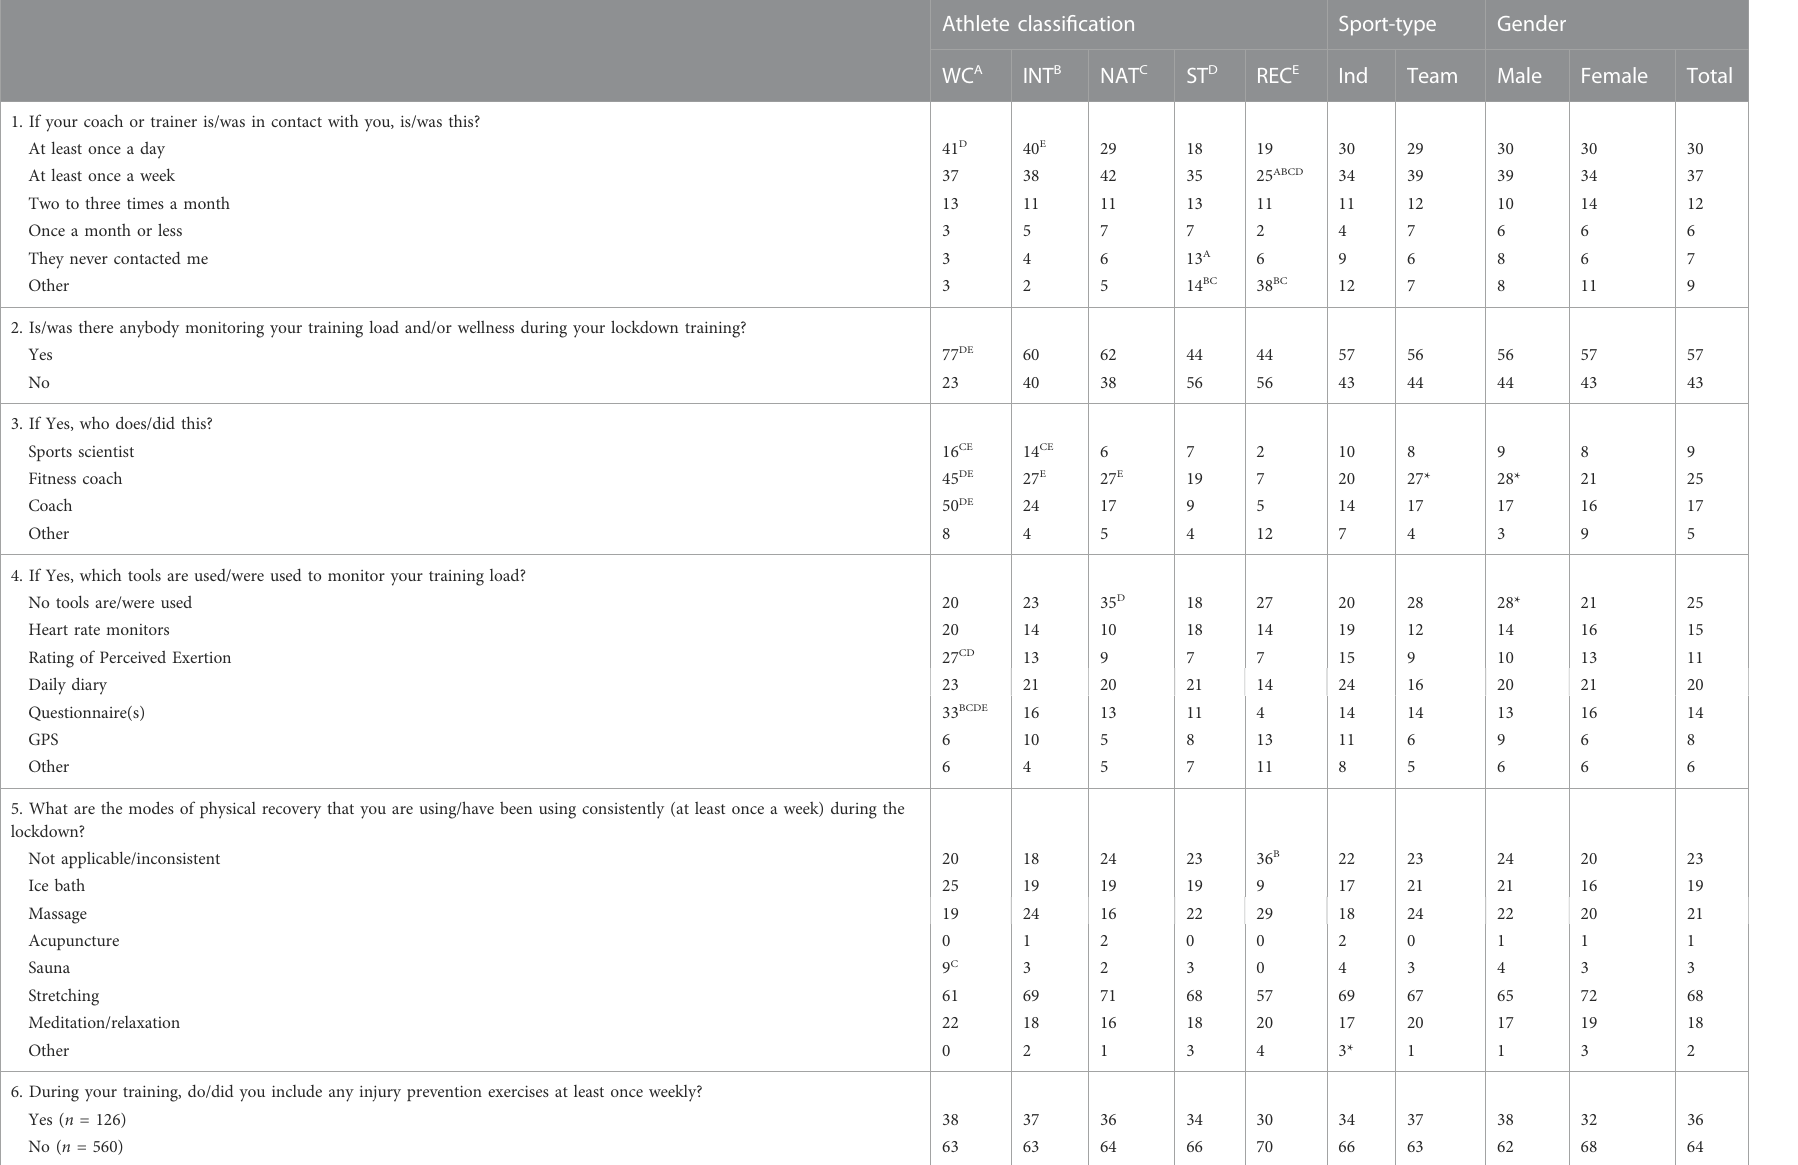
TABLE 3 Monitoring, recovery, and injury by athlete classi fi cation, sport-type, gender, and total cohort, during COVID-19 lockdown in Malaysia (percentage of